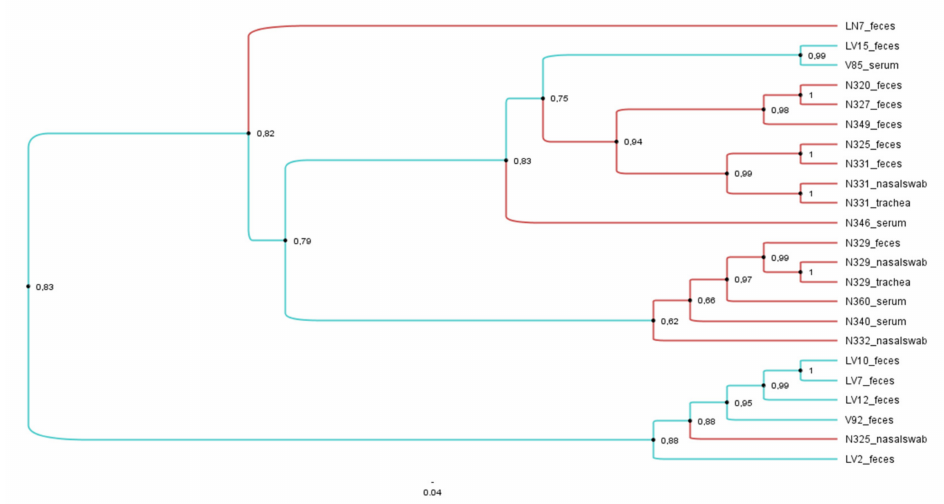
Figure 5. Spatial dynamics of Australian PBV GII. Maximum clade credibility phylogeny inferred under a Bayesian structured coalescent model. The nodes are annotated with the location posterior probabilities. Branches are blue for Victoria and red for New South